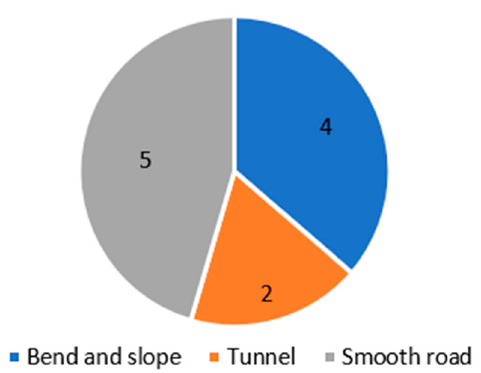
Figure 4. Location-series analysis for commercial vehicle accidents.